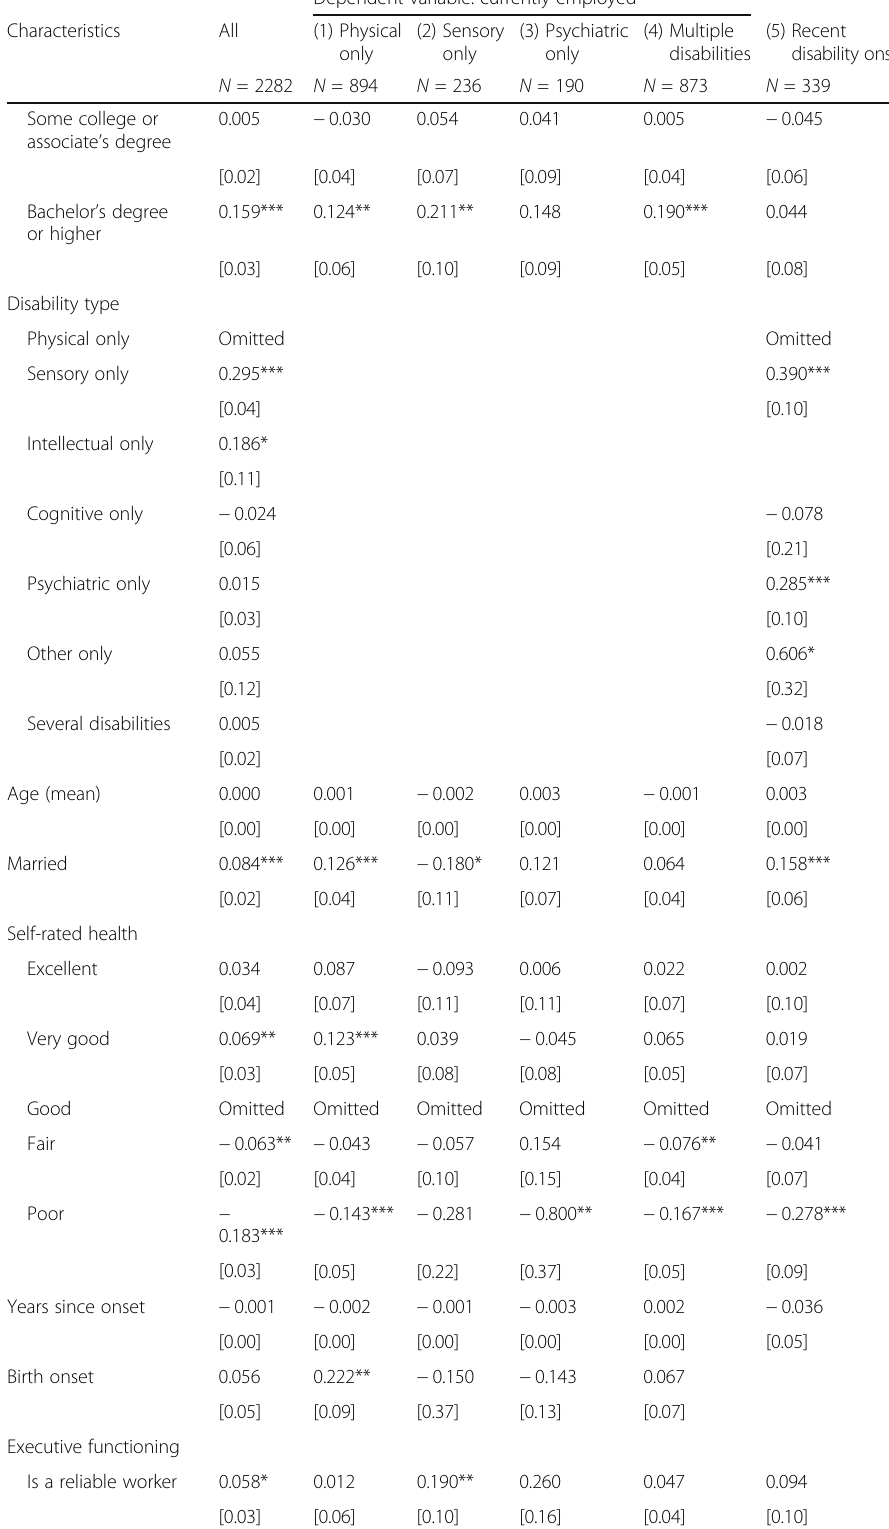
Table 4 Regression results of employment on workplace accommodations, overall, and by disability subgroup